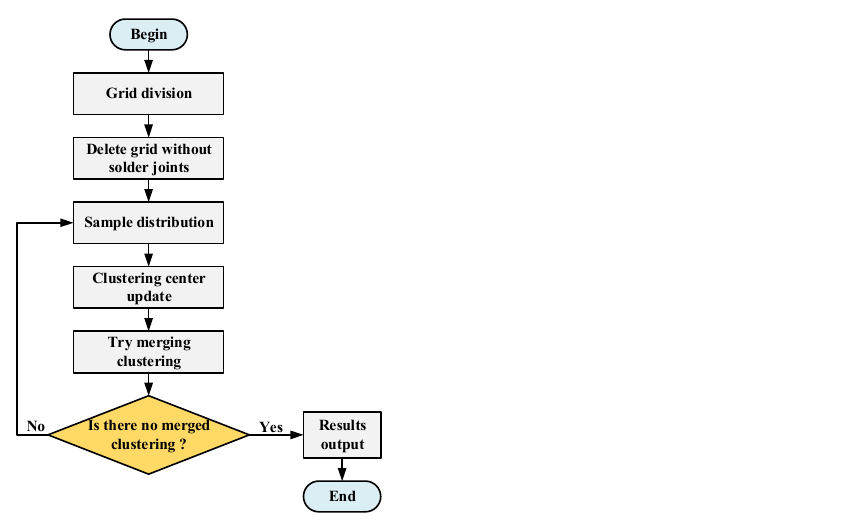
represent the lengths of the machining